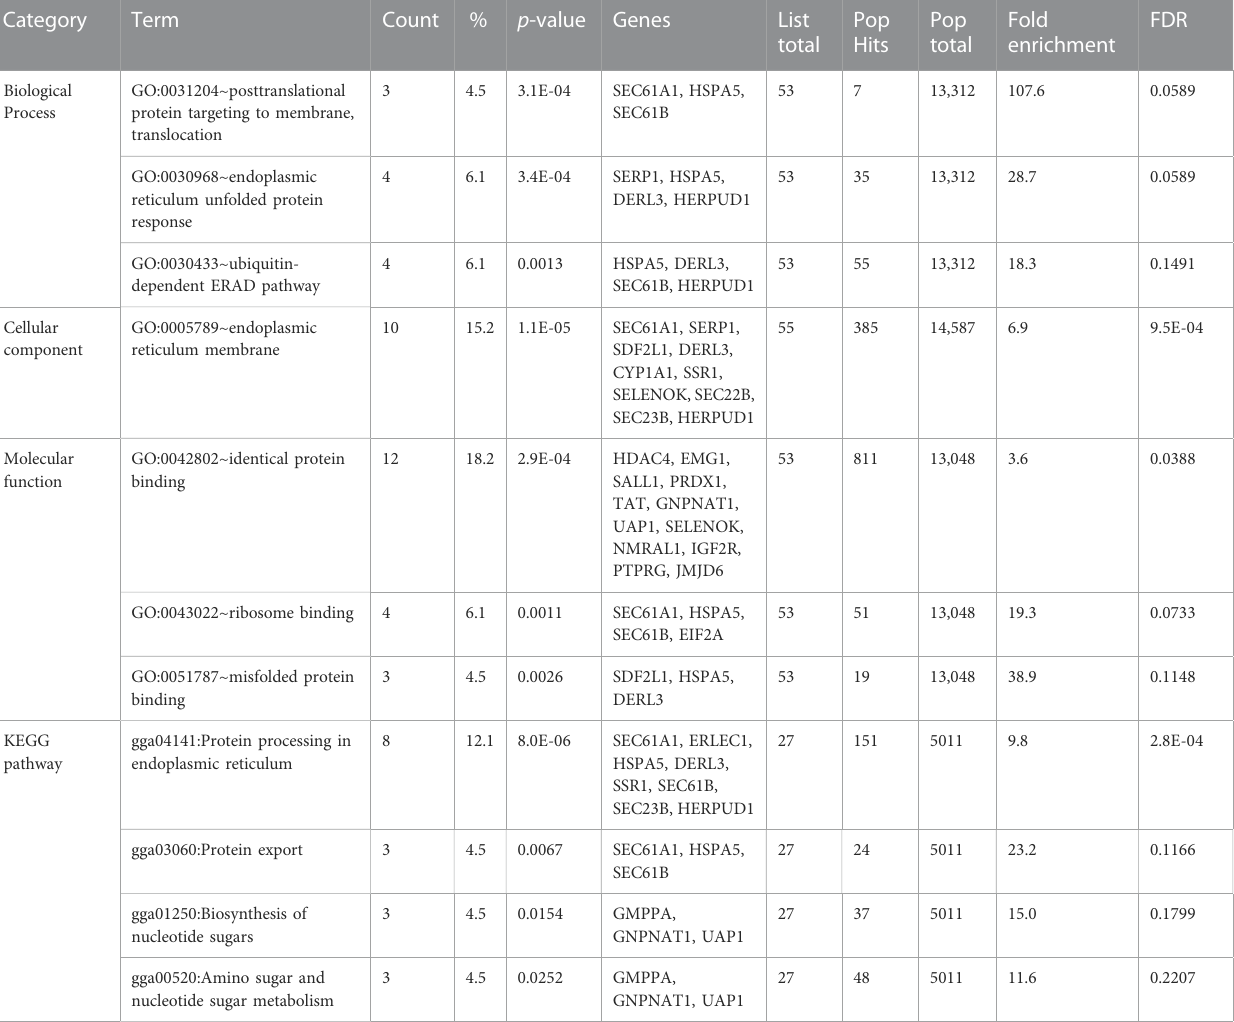
TABLE 2 Gene ontology and KEGG pathway enrichment results of meta-genes in the comparison of chickens under acute heat stress and their corresponding control groups. Category